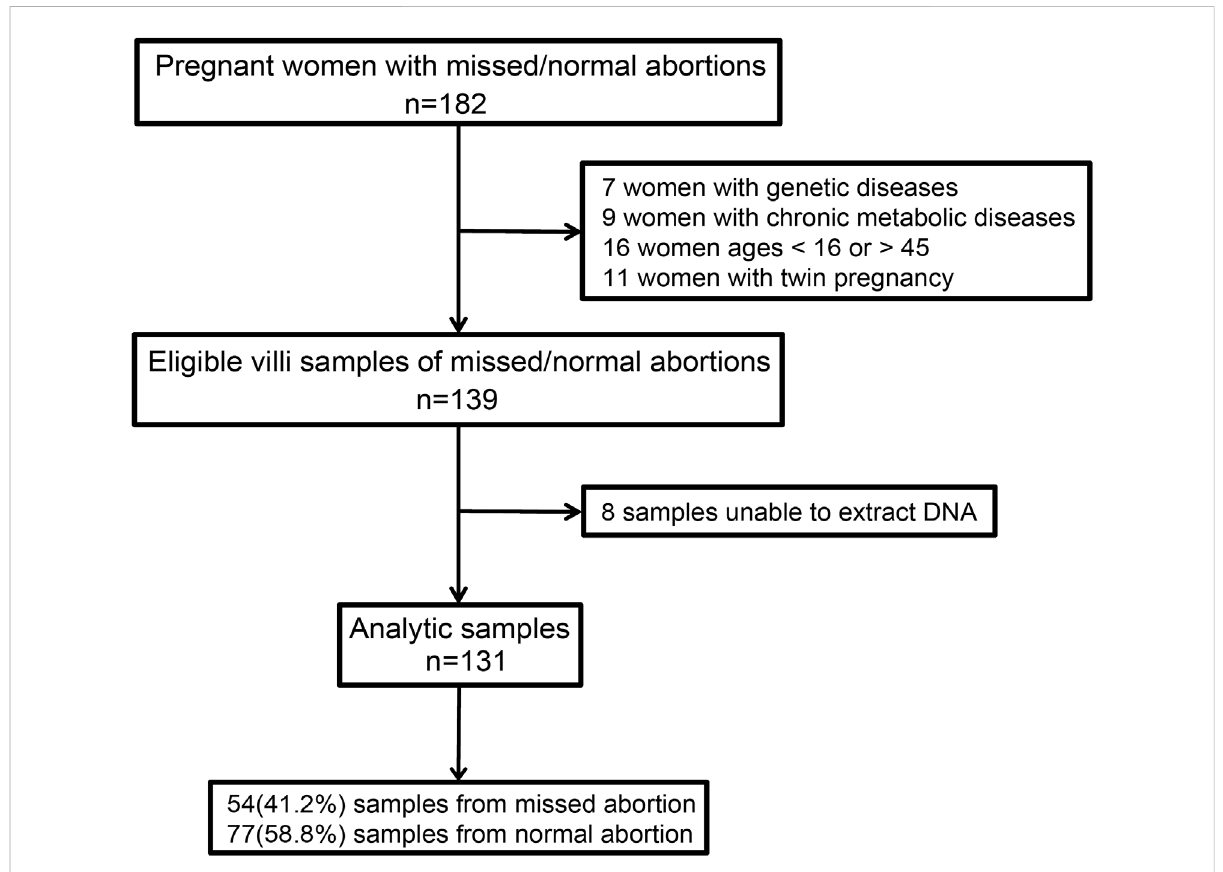
FIGURE 1 The selection process for this